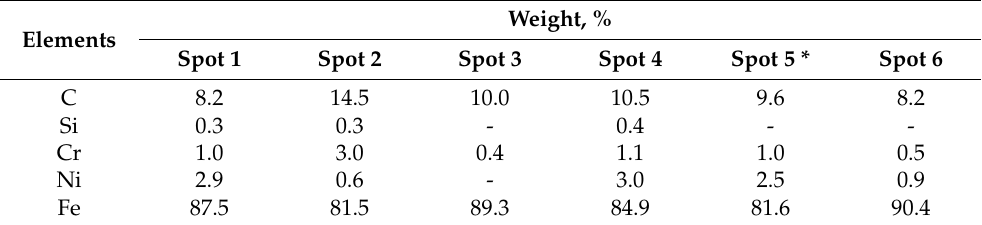
Figure 6. ( a ) SEM micrograph; and ( b ) EDS analysis points showing microstructure of the 20H2N4A . Table 4. EDS analysis results.